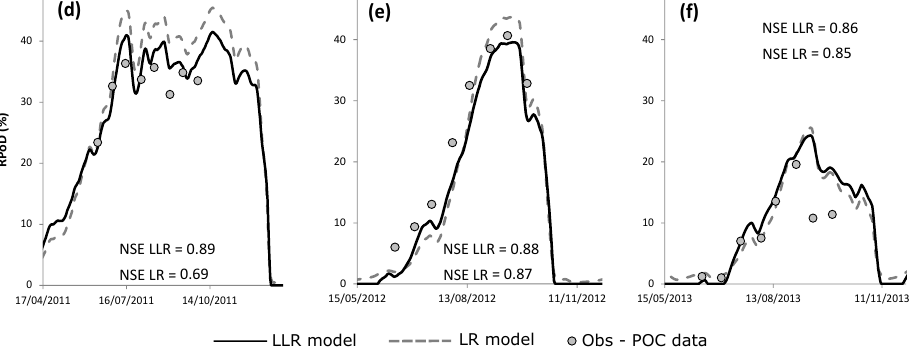
Table 2. NSE criteria obtained between 2012 and 2017 with the LLR and LR models calibrated over the period 2012–2016.